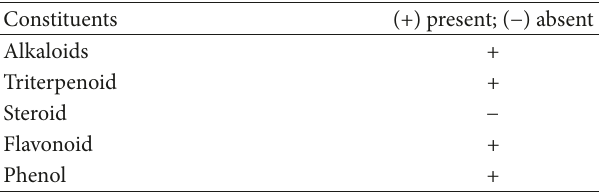
Table 2: Composition of the experimental diet.